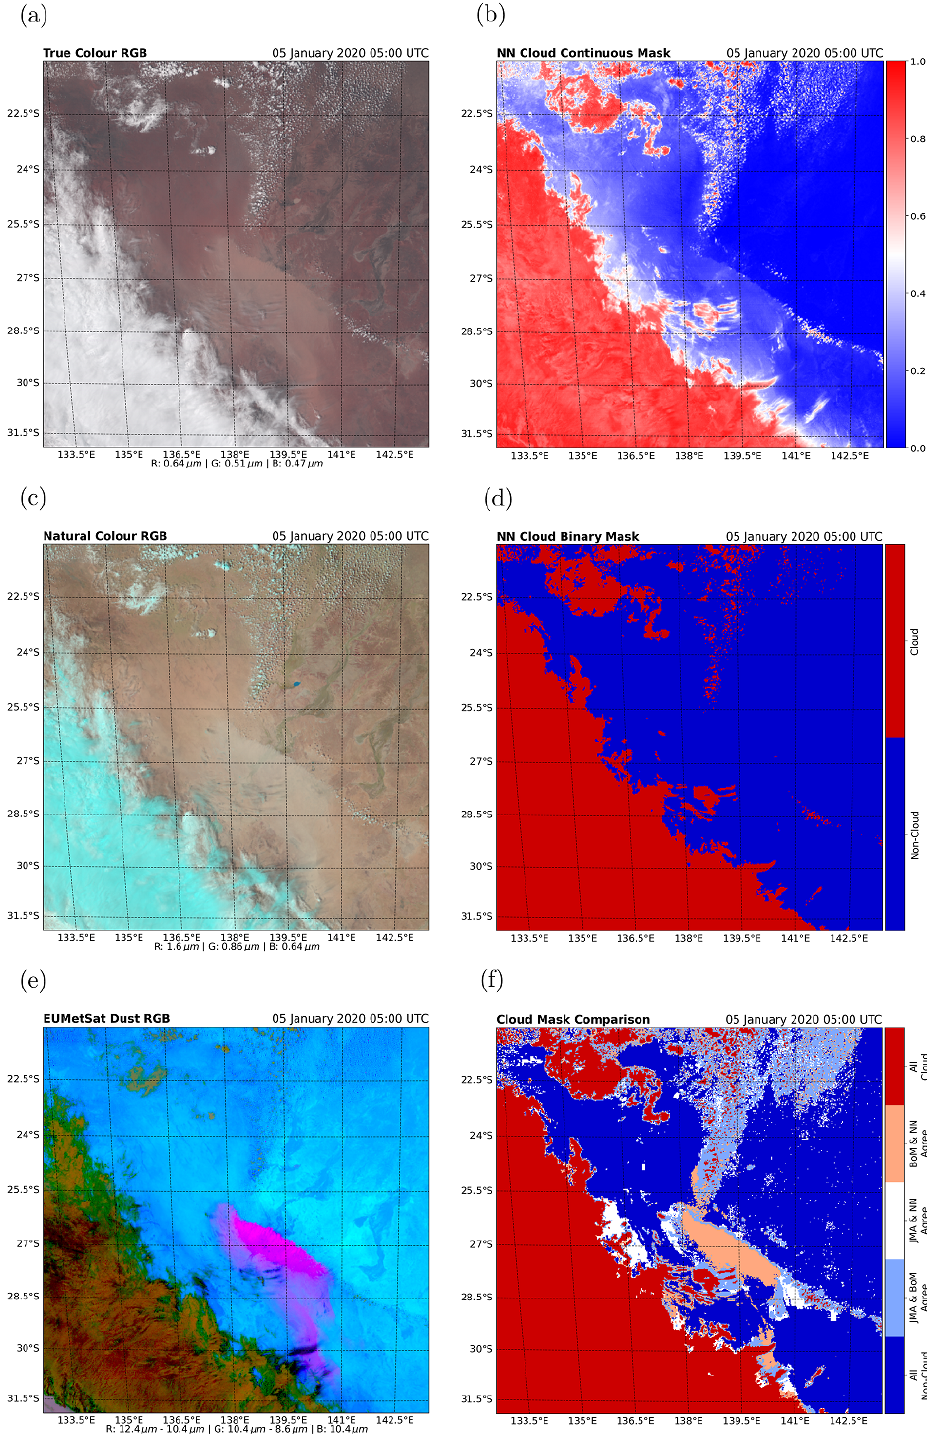
Figure 12. Region C covering central Australia and highlighting a dust storm for 5 January 2020 at 05:00UTC. A total of three RGB false- colour composites of the scene are presented in the left-hand column, showing (a) true-colour, (c) natural-colour and (e) dust RGBs. The top, middle and bottom panels of the right-hand column show (b) the NN continuous cloud mask, (d) NN binary cloud mask and (f) a comparison of the three binary masks for the